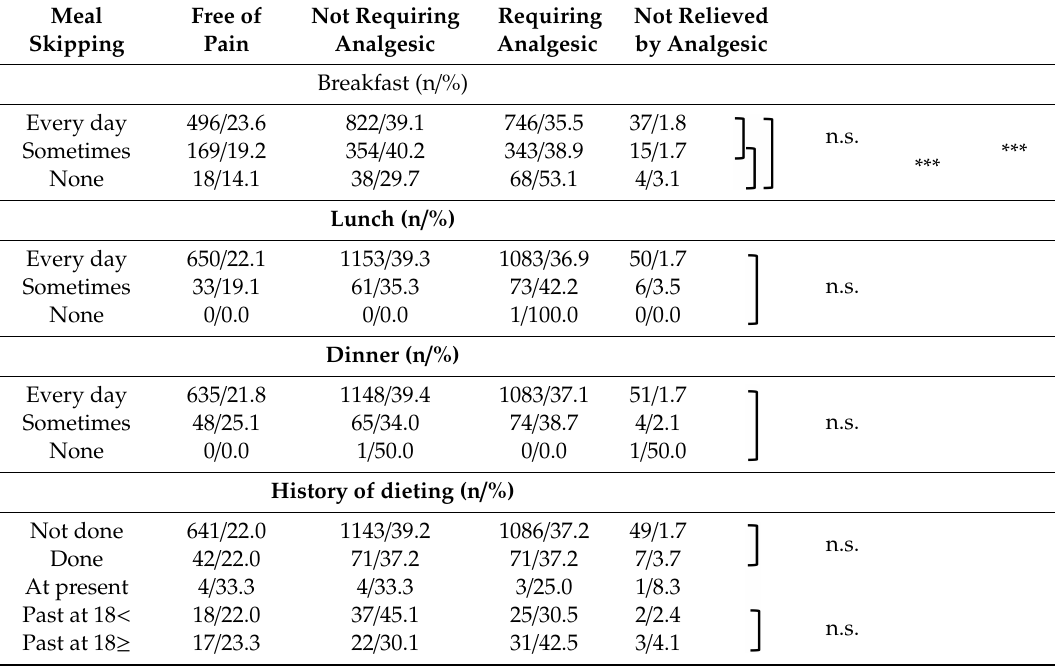
Table 4. Relationship between menstrual pain and meal skipping or dietary habits.